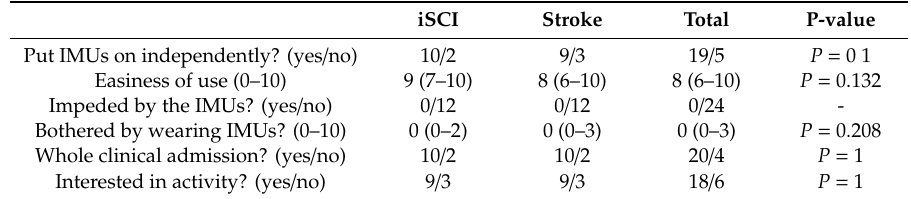
Table 3. Results of the questionnaire on the feasibility regarding the use of Inertial Measurement Units (IMUs) for both patient groups. Results are displayed as total yes / no or as NRS score (median with minimum and maximum